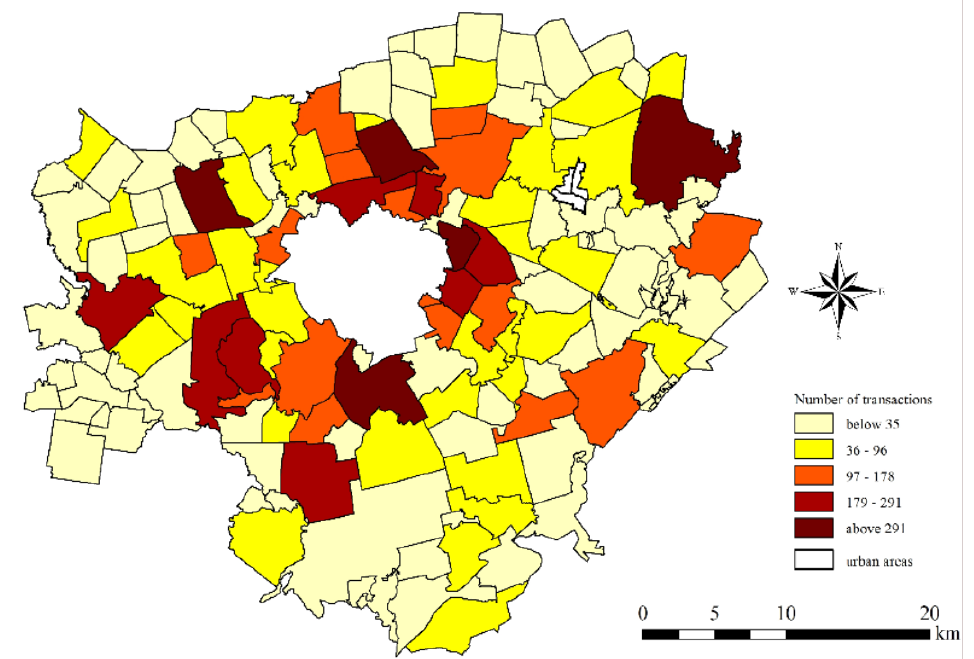
Figure 4. Number of transactions concluded in the cadastral districts of the Olsztyn FUA between 2007 and